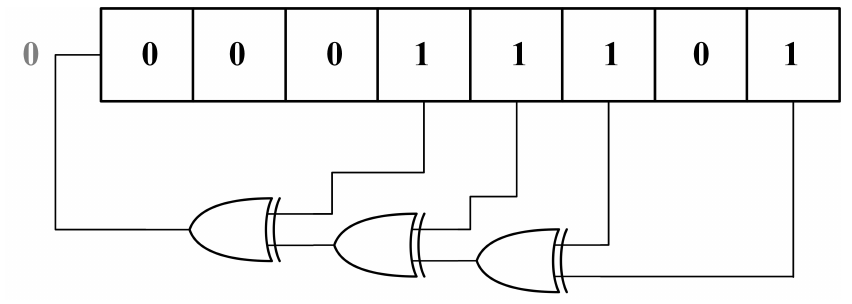
Figure 13. An 8-bit Fibonacci